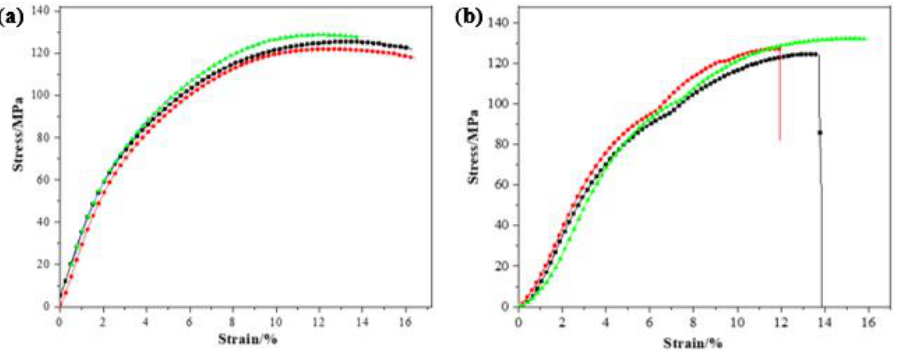
Figure 11. The strain-stress curve of the molded plate: ( a ) before aging and ( b ) after aging. For the stress-strain curve after aging, there is no significant trend of weakening in terms of change and peak. In initial compression, the curve also presents linear change, and the Young’s modulus is 2.32 GPa, 2.36 GPa, and 2.30 GPa, respectively, making for an average value of 2.33 ± 0.03 GPa. It is revealed that after the thermal aging, the Young’s modulus of the molded plate decreases slightly, meaning the aging treatment reduces the rigidity of the molded plate. The maximum compression strength for three compressions after aging is 124.68 MPa, 127.19 MPa, and 132.30 MPa, respectively, with an average value of 128.06 ± 3.17 MPa. The results, which demonstrate that the maximum compression strength after aging is even slightly higher than that before the treatment, indicate that the thermal aging treatment will not produce adverse influences on the compression resistance properties of the molded plate. Table 2 shows the test results of the impact resistance properties of the molded plate before and after aging. According to the results, a good impact resistance properties is presented by the average impact resistance strength of 11.77 ± 0.59 kJ/m 2 before the aging; after the test, the average impact resistance strength is 11.57 ± 0.58 kJ/m 2 , a slight decrease of 1.3% compared with that before the aging. The raw material polyimide is thermosetting. The molecular bond breaks at high temperature, which gradually reduces its mechanical properties. The results show that the material can be used long-term under 300 °C.